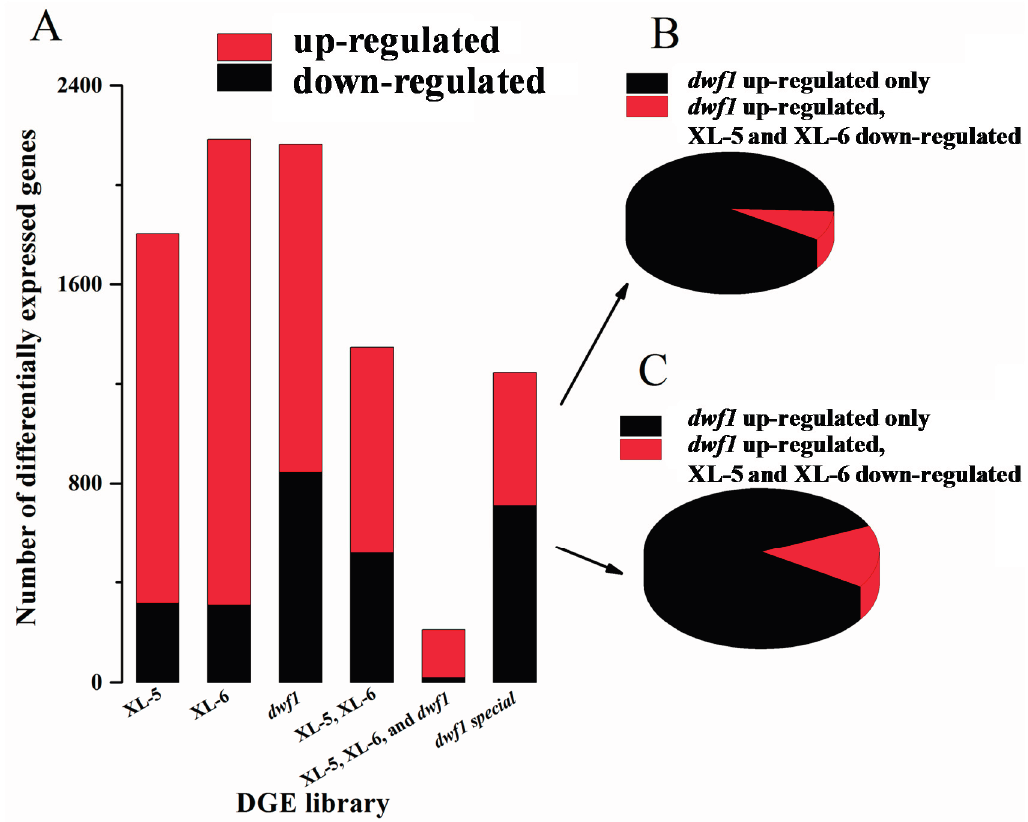
Figure 2. Distribution of differentially expressed genes. ( A ) Exact numbers of differently expressed genes. XL-5, XL-6, and dwf1 indicate differently expressed genes in each sample in compared to wild-type (WT); “XL-5, XL-6” indicates common differently expressed genes in XL-5 and XL-6; “XL-5, XL-6, and dwf1 ” indicates common differently expressed genes in XL-5, XL-6 and dwf1 ; “ dwf1 special” indicates differentially expressed genes that were only identified in dwf1 ; ( B ) Expression patterns of dwf1 special up-regulated genes in XL-5 and XL-6; ( C ) Expression patterns of dwf1 special down-regulated genes in XL-5 and